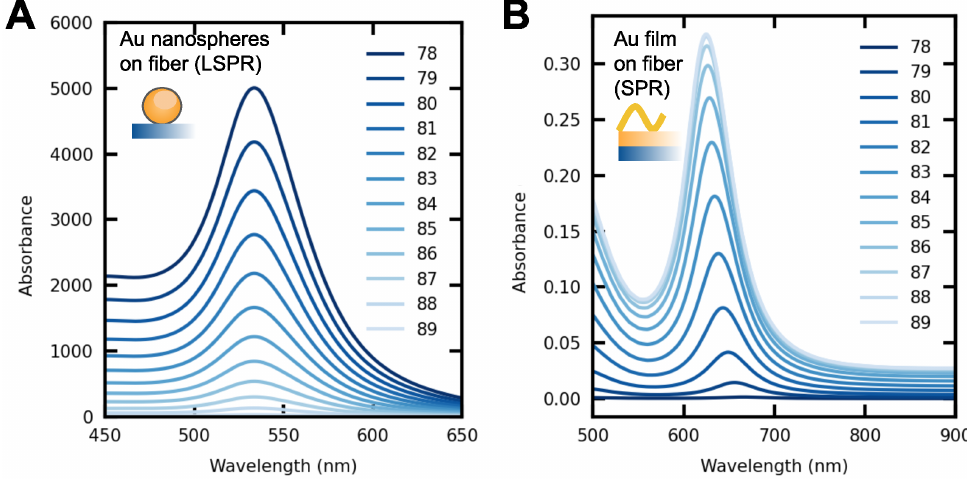
Figure A2. Spectral dependency upon the incident light angle for plasmonic structures based on ( A ) nanoparticles and ( B ) metallic thin